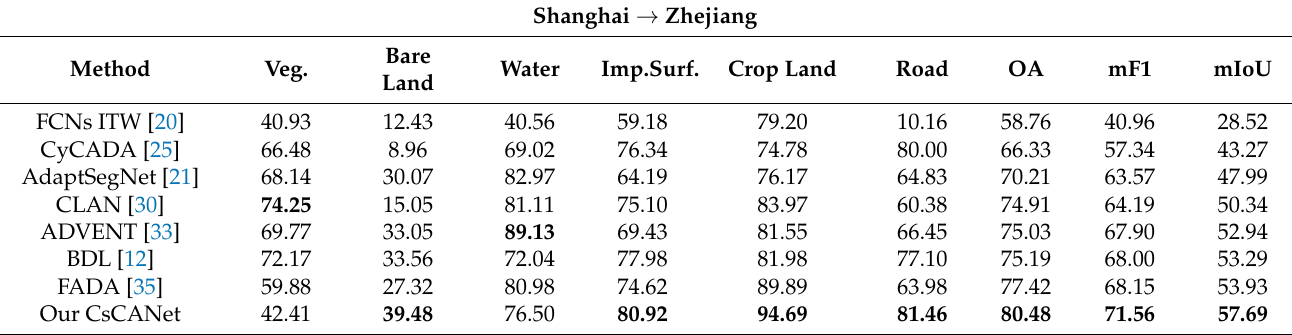
Table 3. Comparison results on the task Shanghai → Zhejiang (%). We study the performance using the Shanghai dataset as annotated source data and the Zhejiang training set as the unlabeled target domain. The best results are highlighted in bold.